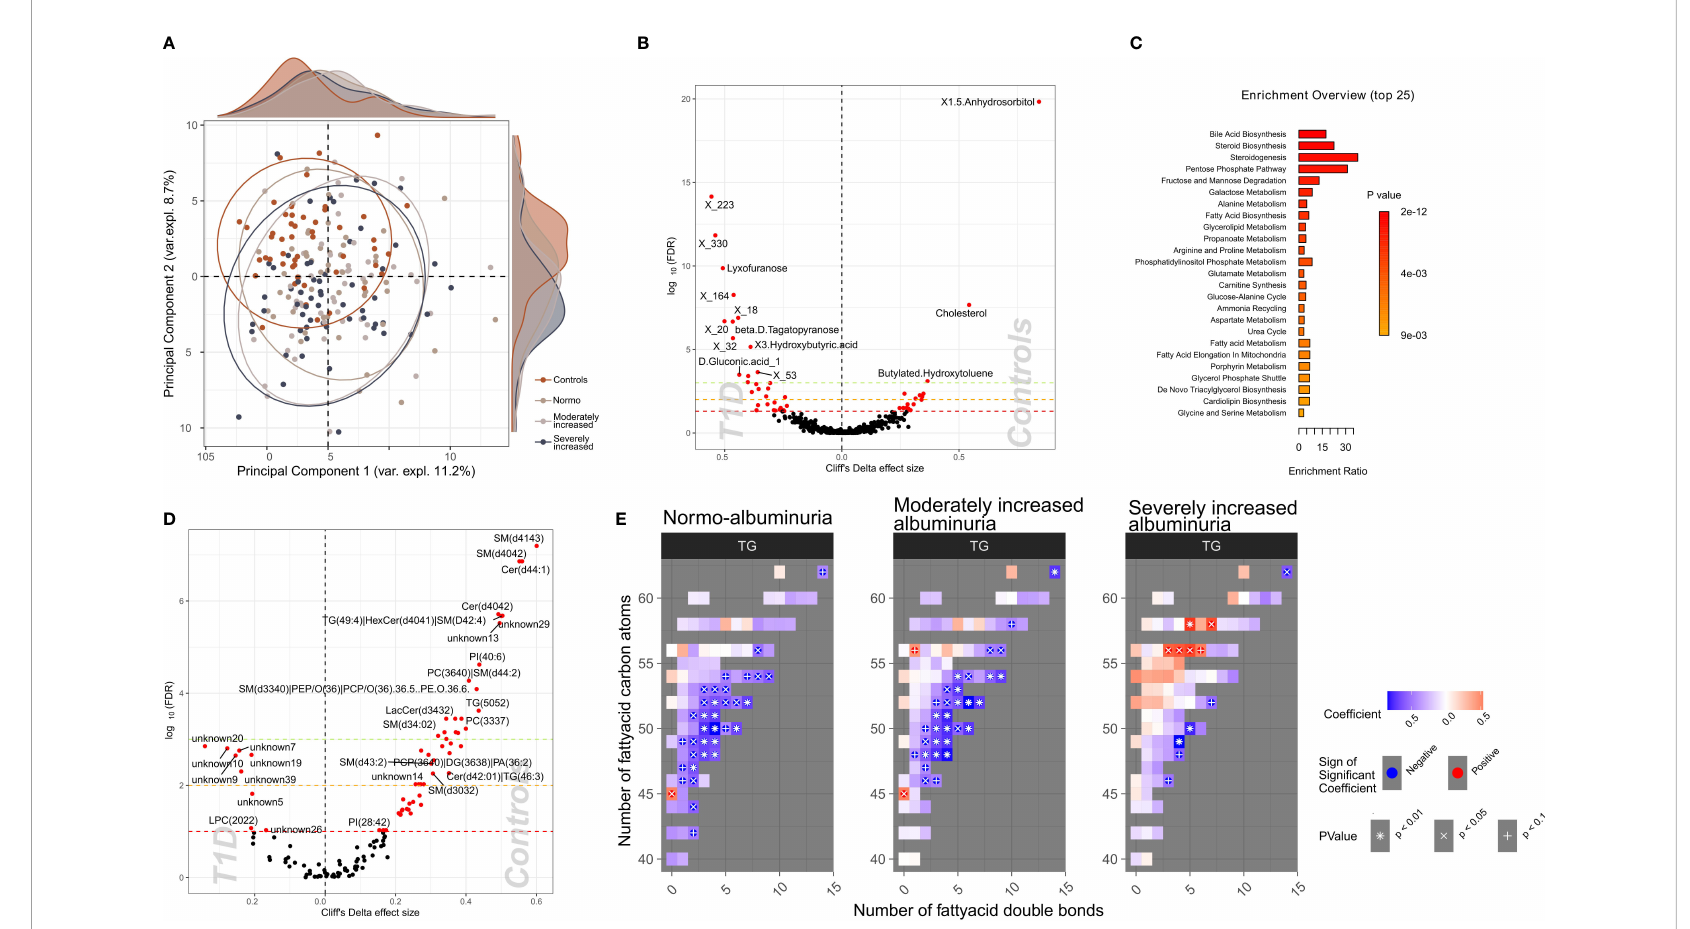
FIGURE 4 Pro fi les of plasma polar metabolites and lipids in T1D and healthy control individuals. (A) Scores plot resulting from the partial least square discriminant analysis (PLS-DA) demonstrating polar metabolites that contribute highly (Variable in fl uence on project (VIP) > 1) to a T1D signature. Colors depict clinical study groups and ellipses demarcate the spread of individuals within each group. Explained variance for fi rst two principal components (PC1 and PC2) is indicated on the respective X- and Y- axis. Global distribution of the participants from each clinical group is shown as a density plot in the secondary Y-axis. (B) Univariate analysis (volcano plot) depicting differential circulating polar metabolite abundances between healthy and T1D individuals. Signi fi cantly contrasted (FDR < 10%) polar metabolites are depicted in red, with increasing effects in direction of controls (right). (C) Functional metabolic pathway identi fi cation comparing T1D and healthy controls and depicting enriched metabolic pathways: annotations of top polar metabolites using the human metabolome database (HMDB). Bars have been ordered and colored by the enrichment p-value score. (D) Univariate analysis (volcano plot) depicting differential abundances of serum lipid cluster between healthy and T1D individuals. Signi fi cantly contrasted (FDR < 10%) lipid clusters are colored in red with increasing effects in direction of controls (right). (E) Triglyceride (TG) species associated with different T1D albuminuria groupings (compared to healthy controls) based on the number of carbon atoms (Y-axis) and the number of double bonds (X.axis) present in the chemical structure. Blue-to-red gradient heatmap suggests directionality of the association (negative to positive). Signi fi cant associations are indicated in each cell with the following symbols: + p<0.1, X p<0.05,